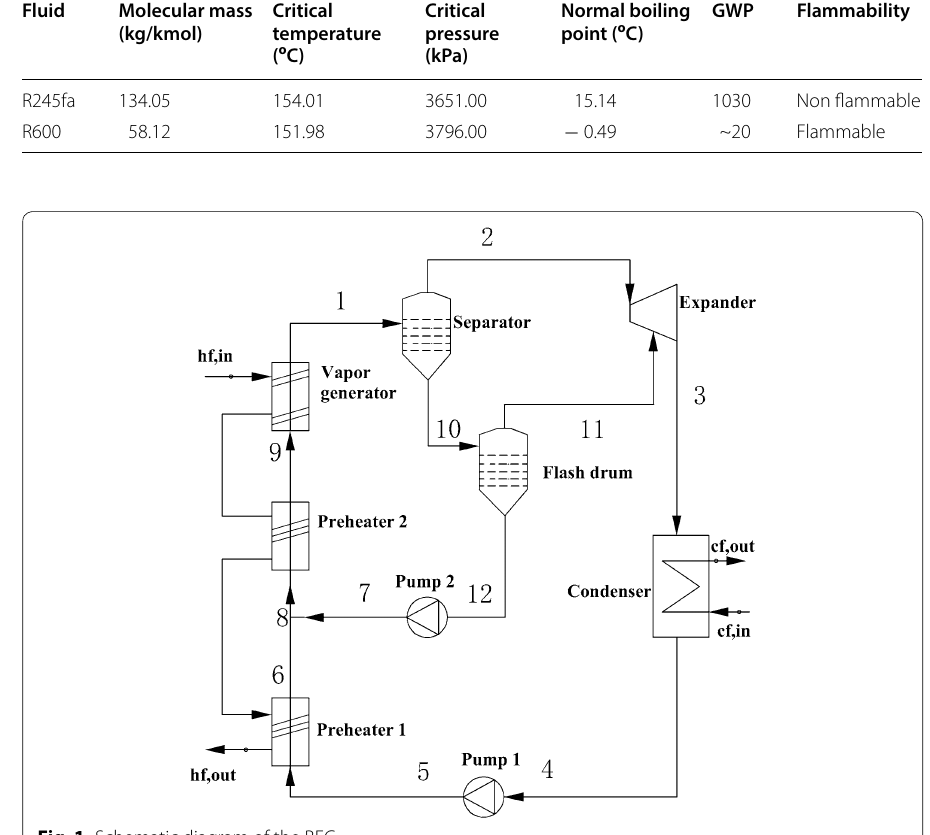
Fig. 1 Schematic diagram of the